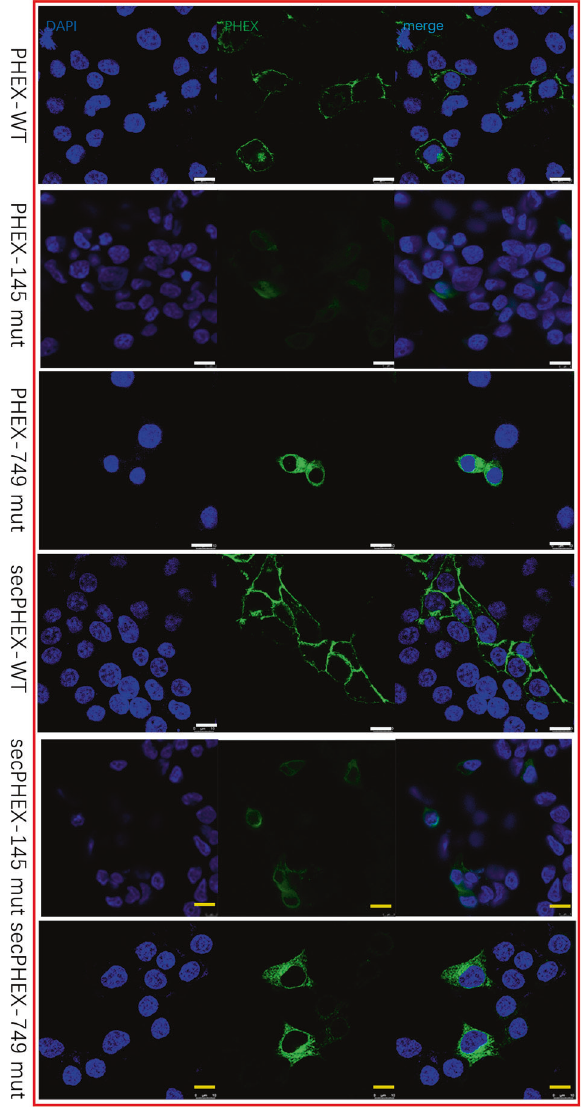
Fig. 2 The localization of wild type and mutant PHEX and secPHEX, as detected using immuno fl uorescence in HEK293T cells single-transfected with PHEX and sec PHEX . Wild-type PHEX and secPHEX proteins are mainly located in the cell membrane and cytoplasm, while the localization of p.Glu145* and p.Trp749Arg mutated PHEX and secPHEX proteins in the cells changes such that they are widely distributed. At the same time, the expression of mutant PHEX and secPHEX proteins decreases signi fi cantly, espe- cially the p.Glu145* mutants. Scale bar, 8 μ